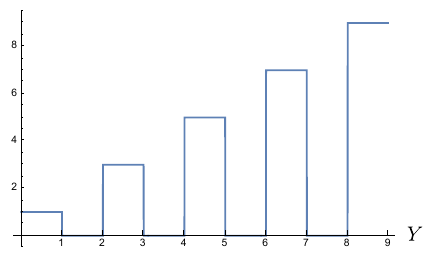
Figure 5 . The integrated spectral density R Y